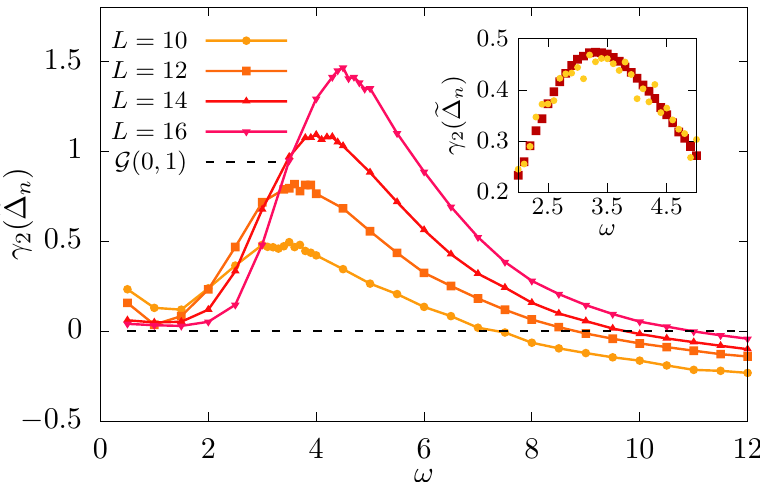
( ∆ ) , Eq. (7), as a function of the disorder (cid:101) n 2 ( 0,1 ) , γ ( ) = 0. 2 G G